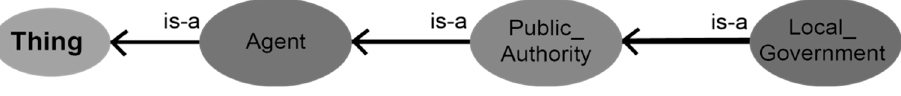
Figure 4. Agent Figure 4. Agent concept. Figure 4. Agent concept.